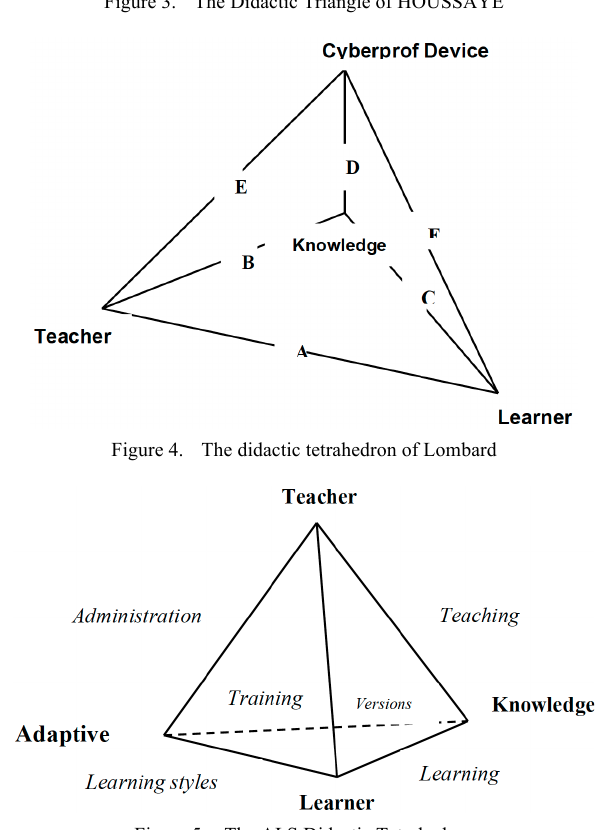
Figure 5. The ALS Didactic